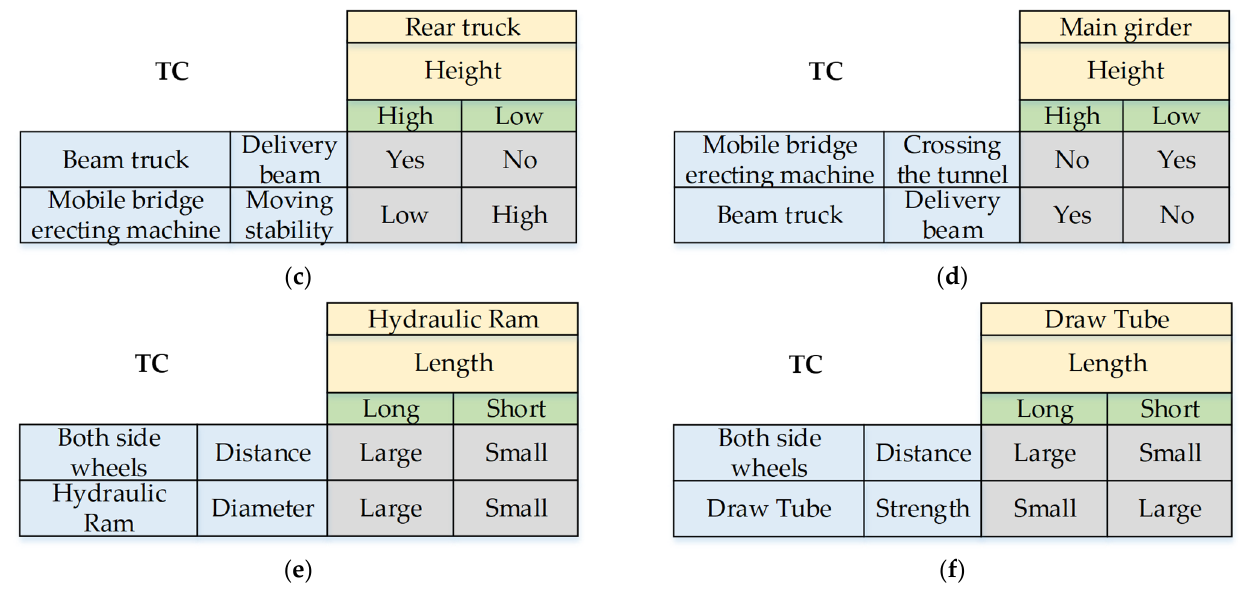
Figure 24. ( a ) Conflict C 1 ; ( b ) Conflict C 2 ; ( c ) Conflict C 3 ; ( d ) Conflict C 4 ; ( e ) Conflict C 5 ; ( f ) Conflict C 6 .